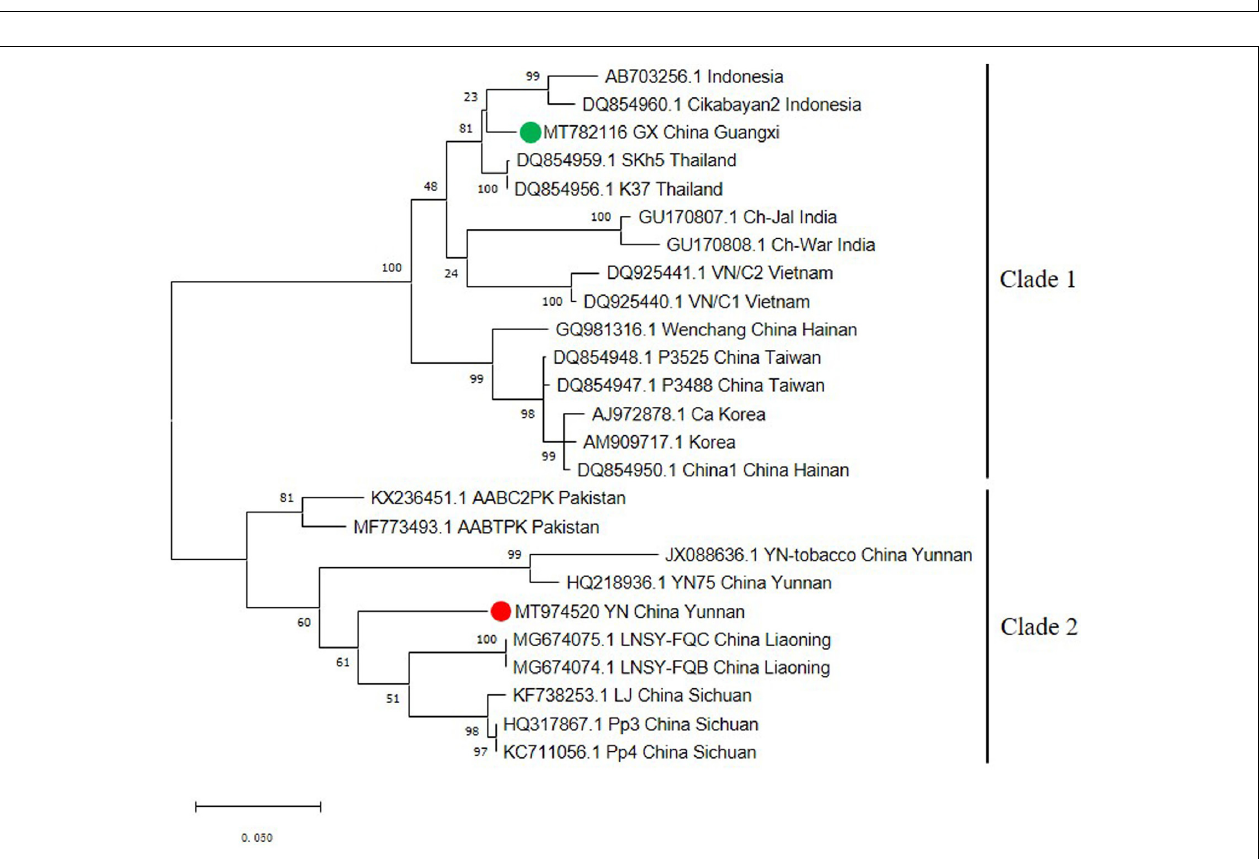
FIGURE 2 | Phylogenetic tree based on the nucleotide sequences of the CP gene of 25 ChiVMV isolates. The phylogenetic tree was produced using MEGA X by the maximum-likelihood (ML) method using the Tamura 3-parameter algorithm and 1,000 bootstrap replications. The number at each branch of the phylogenetic tree is the bootstrap percentage. The tree was divided into two clades and the new Guangxi and Yunnan isolates are marked by green and red circles, respectively.